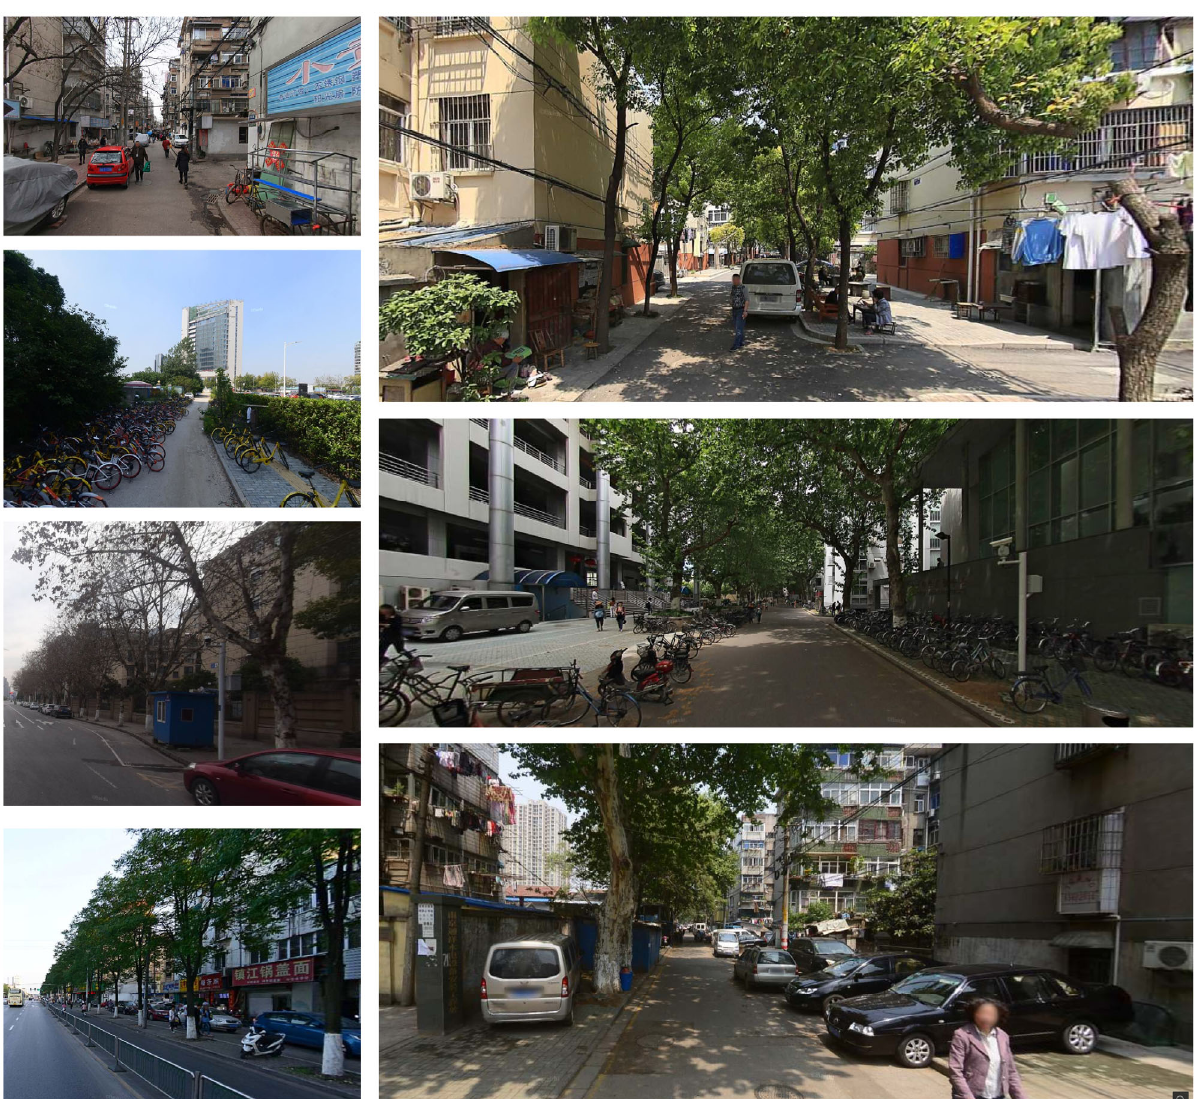
Figure 17. The representative scenes for HS1.RS3.